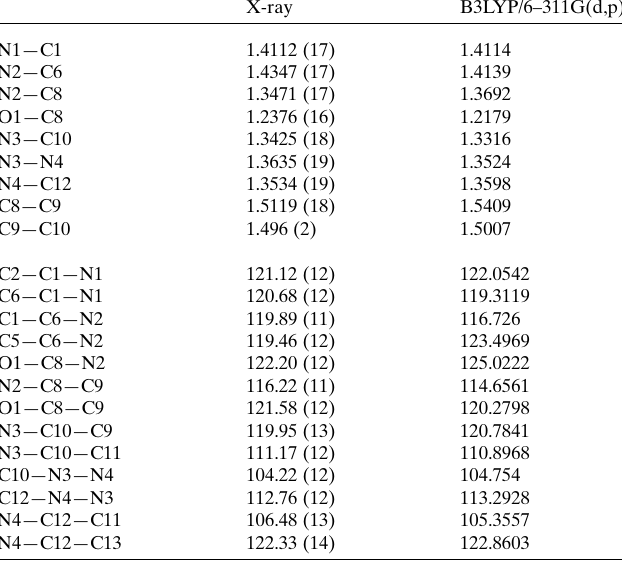
Table 2 Comparison of selected (X-ray and density functional theory) bond lengths and angles (A˚ , (cid:3) ).